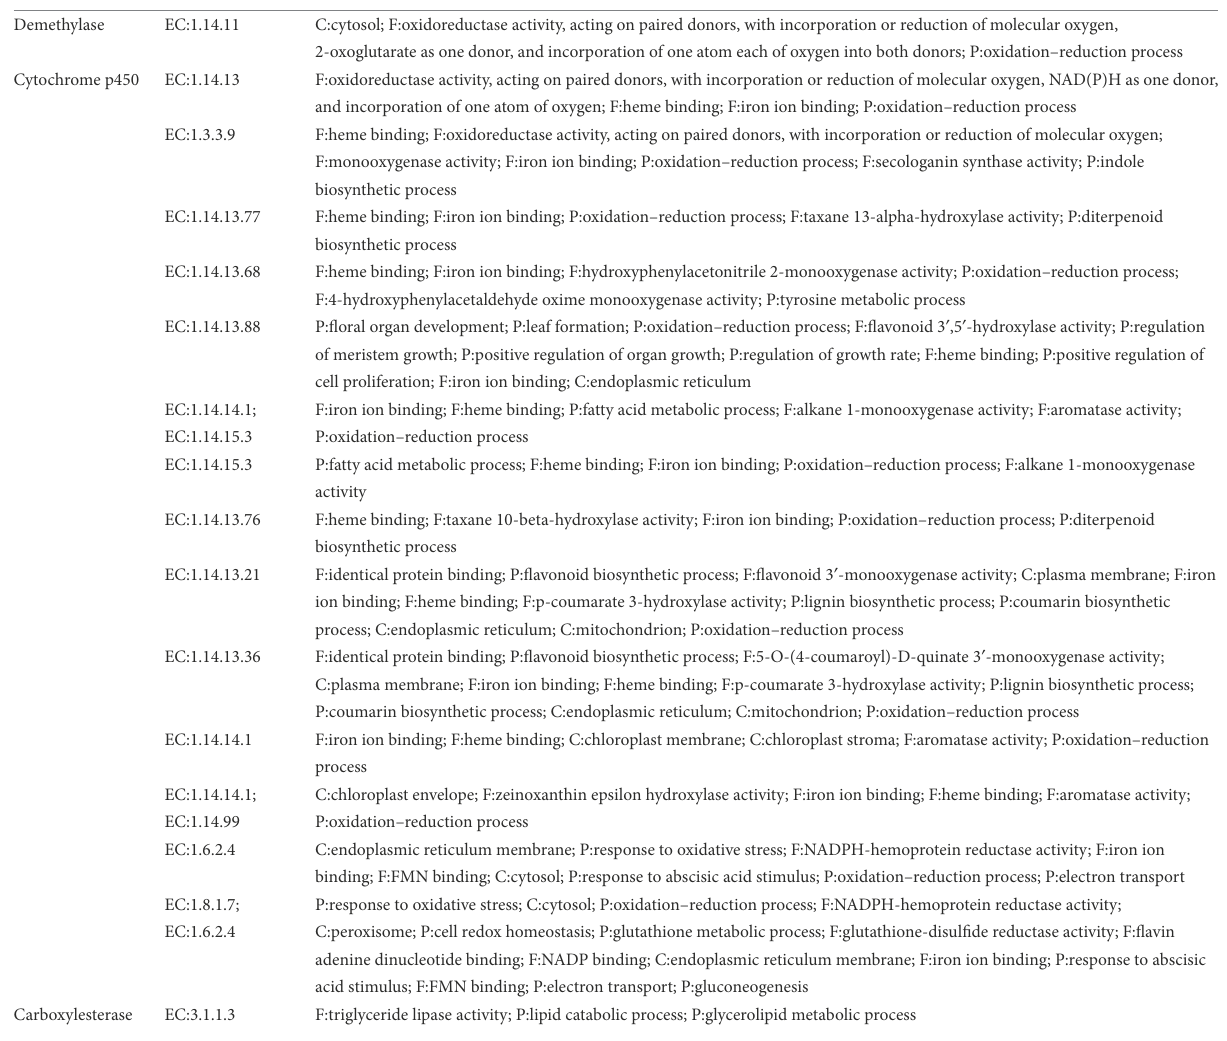
TABLE 3 Candidate gene families associated with physalin biosynthesis.